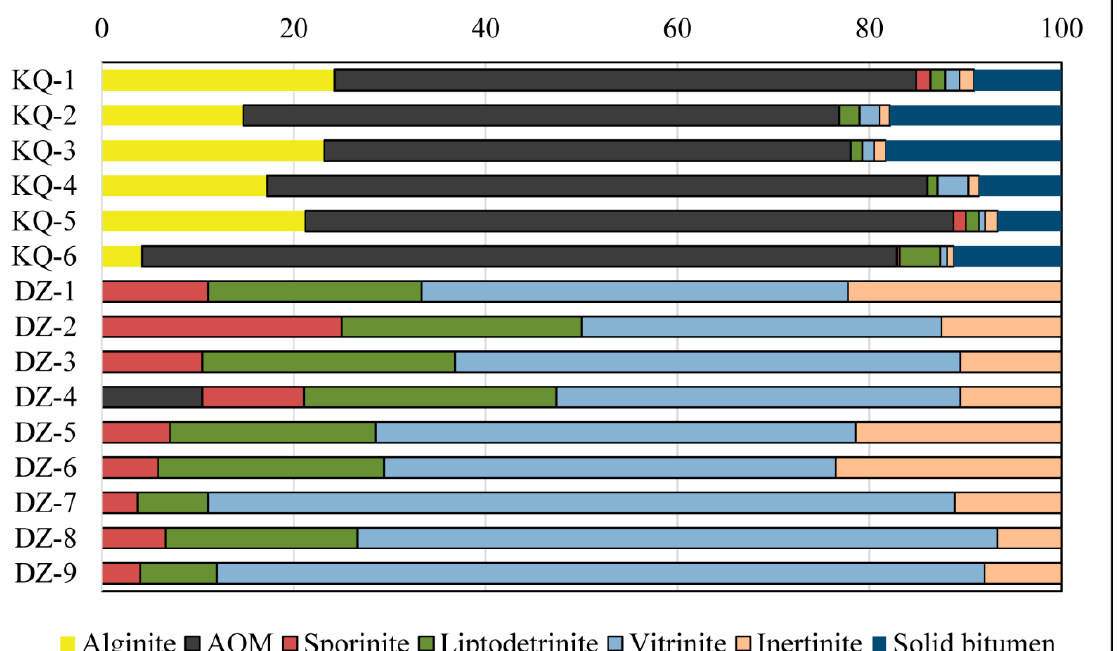
Figure 3. Maceral compositions of the studied Chang 7 Member shale samples determined by point counting. AOM = amorphous organic matter.